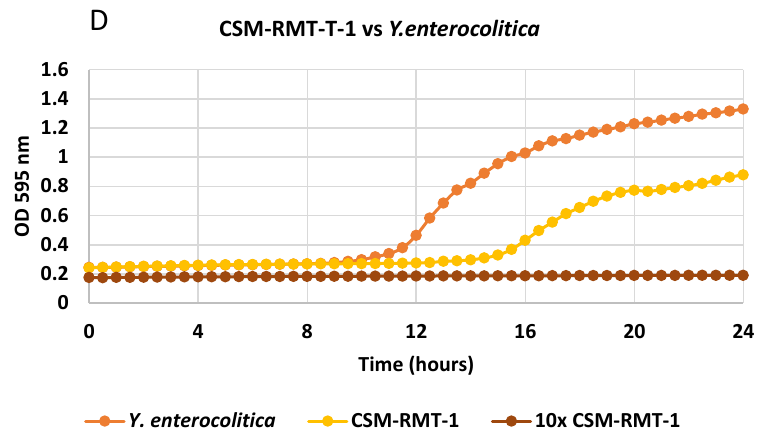
Figure 2. ( A – D ). Effect of non-lyophilised and concentrated (10 × ) cell-free supernatants of S. marcescens CSM-RMT-1 on growth of the tested foodborne pathogenic bacteria (( A ): Salmonella Hartford, ( B ): E. coli , ( C ): L. monocytogenes , ( D ): Y. enterocolitica ).